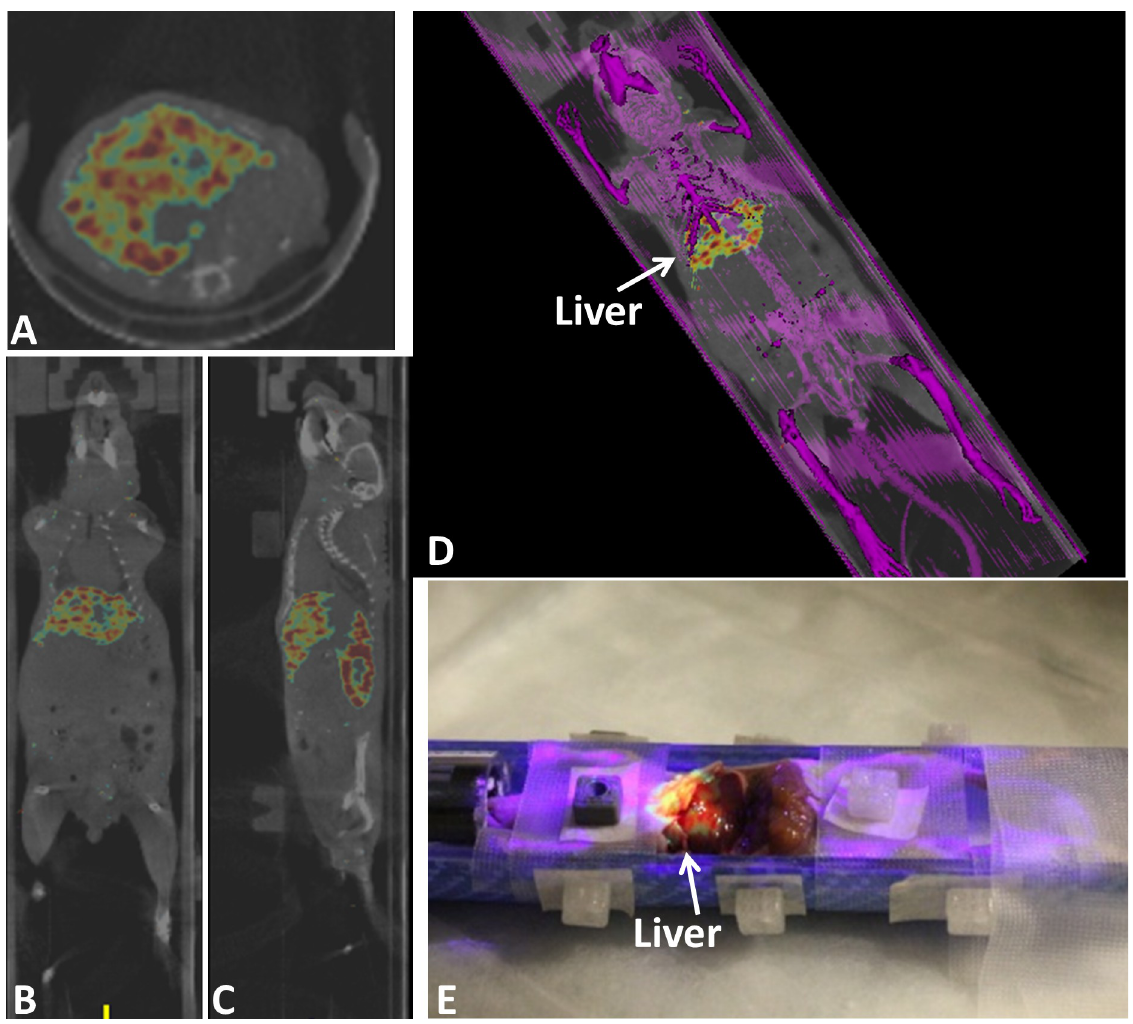
Fig 5. Augmented reality guided procedure with the tumor bearing athymic CD-1 nude mouse using registered SPECT/CT image. (A), (B) and (C) axial, coronal and sagittal images of fused SPECT/CT images respectively. SPECT signal is seen in rainbow and CT in gray. (D) an augmented reality projection image showing surface rendering of bone in purple combined with SPECT/CT coronal slice. (E) mouse dissection mouse demonstrating augmented reality projection SPECT-CT images overlaid on the mouse body also highlighting isotope uptake by the